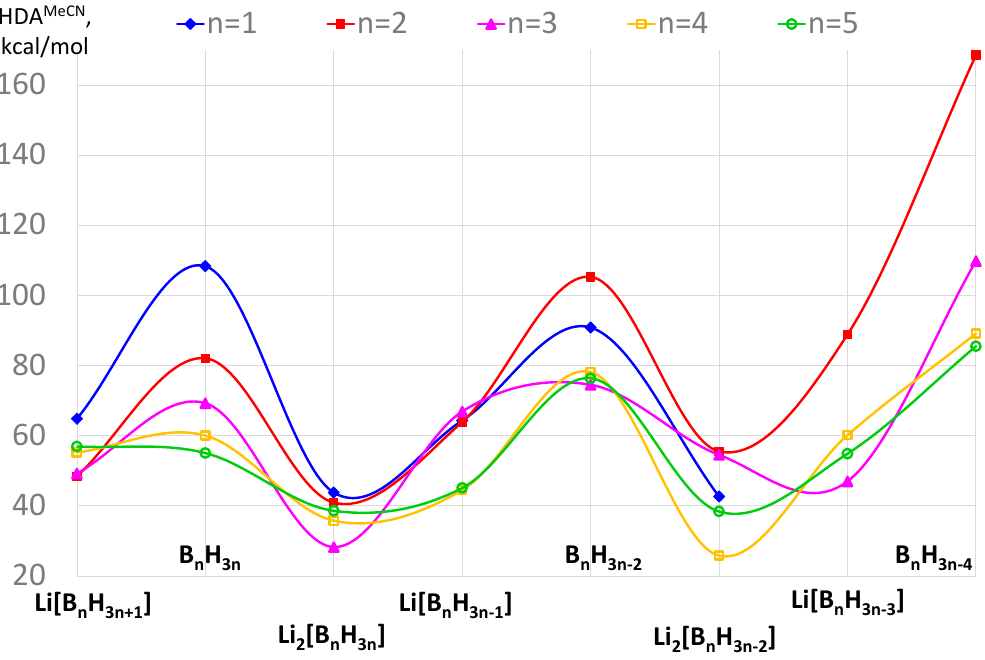
Figure 1. Plot of HDA MeCN for borane clusters of different size.